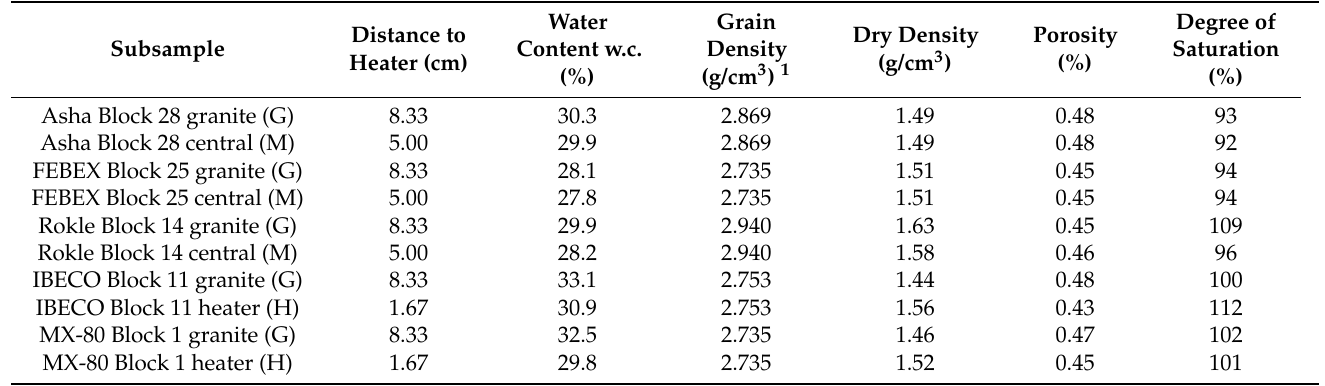
Table 4. Physical properties of bentonite blocks analysed (see locations in Figure